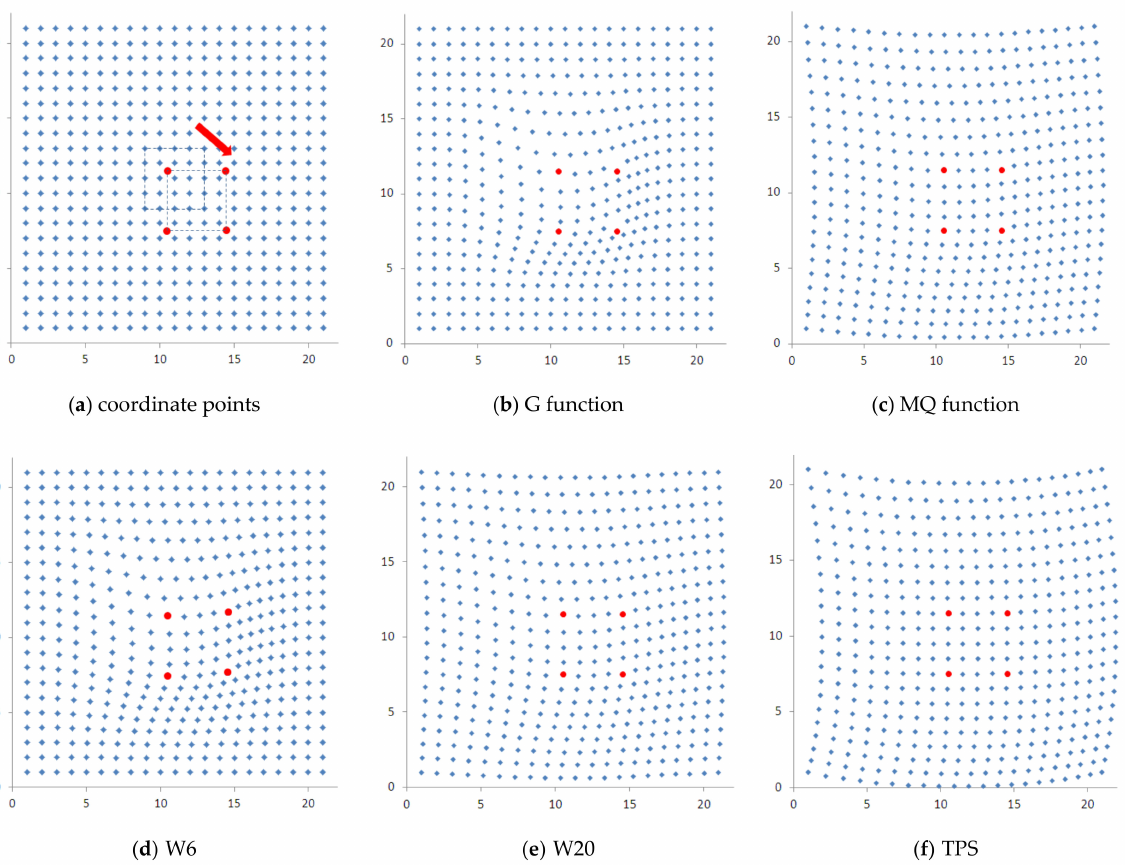
Figure 4. Translation results obtained using the basis